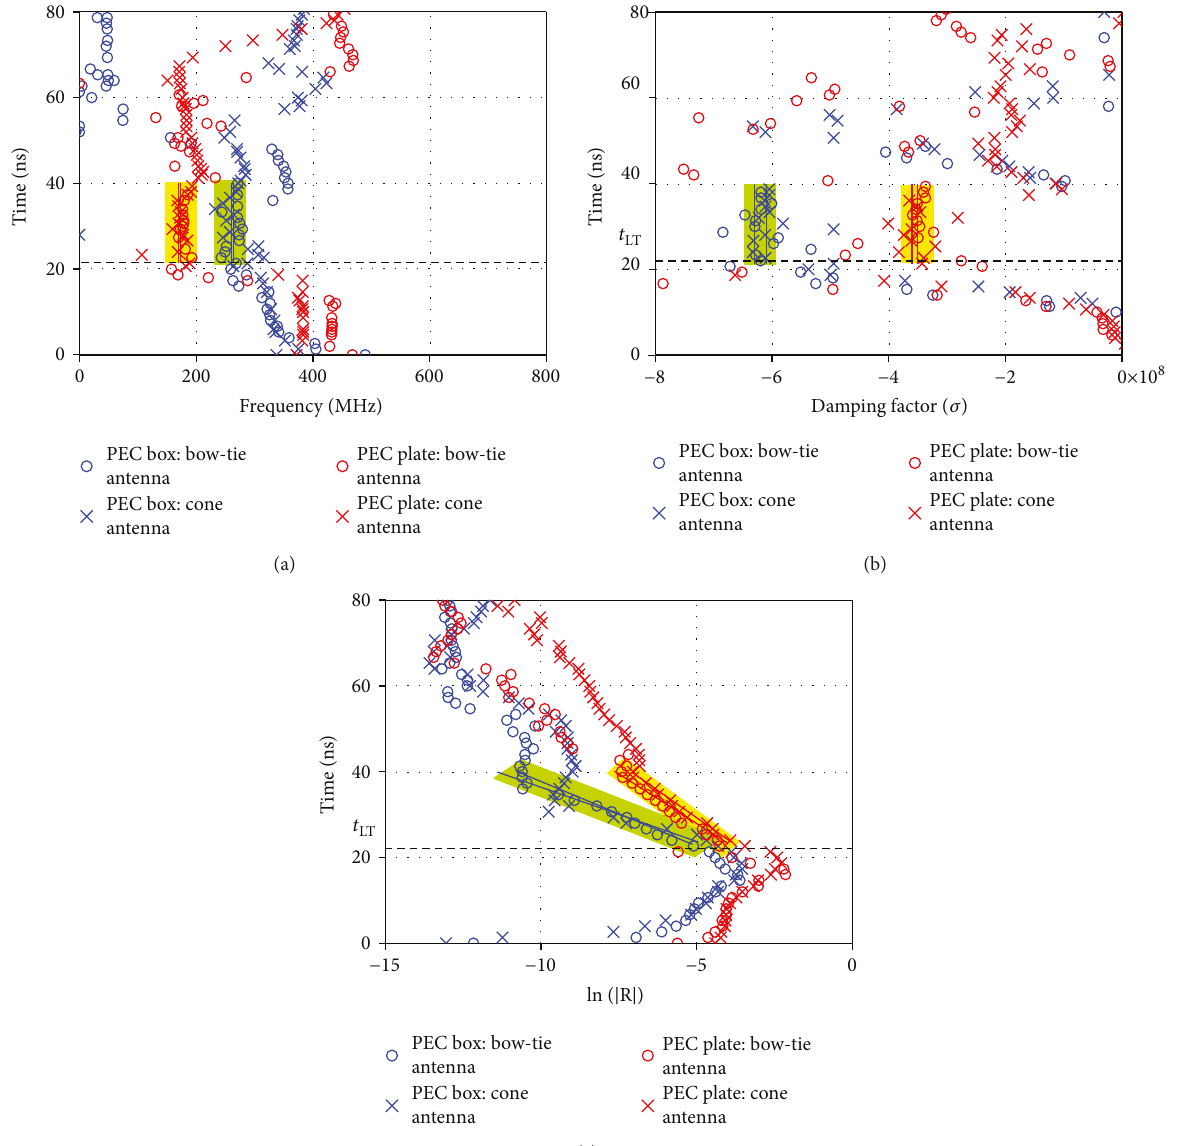
Figure 4: Extracted poles from simulations with fi ltering the antenna e ff ects; (a) imaginary part (b) real part, and (c) magnitude of